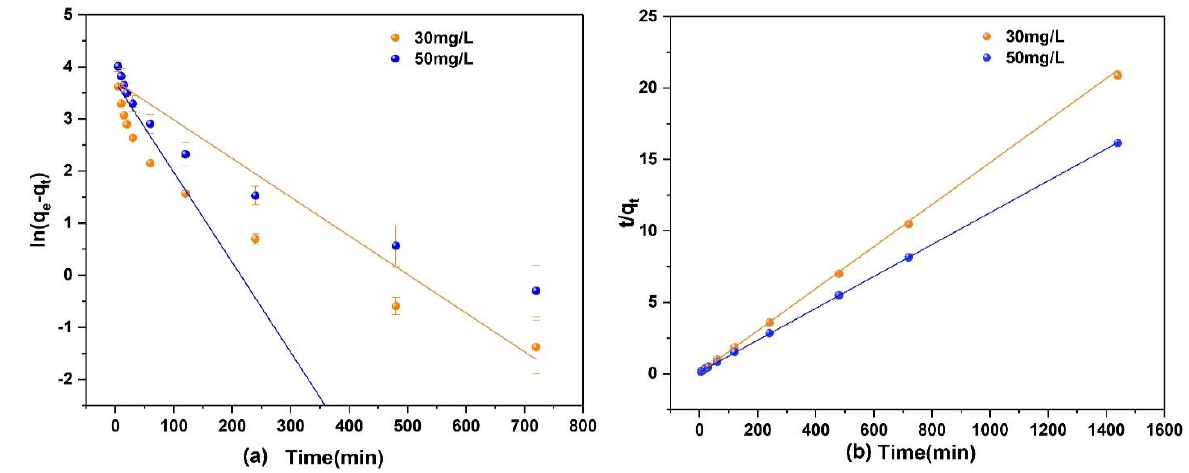
Figure 4. ( a ) Pseudo-first order model; ( b ) Pseudo-second order model.